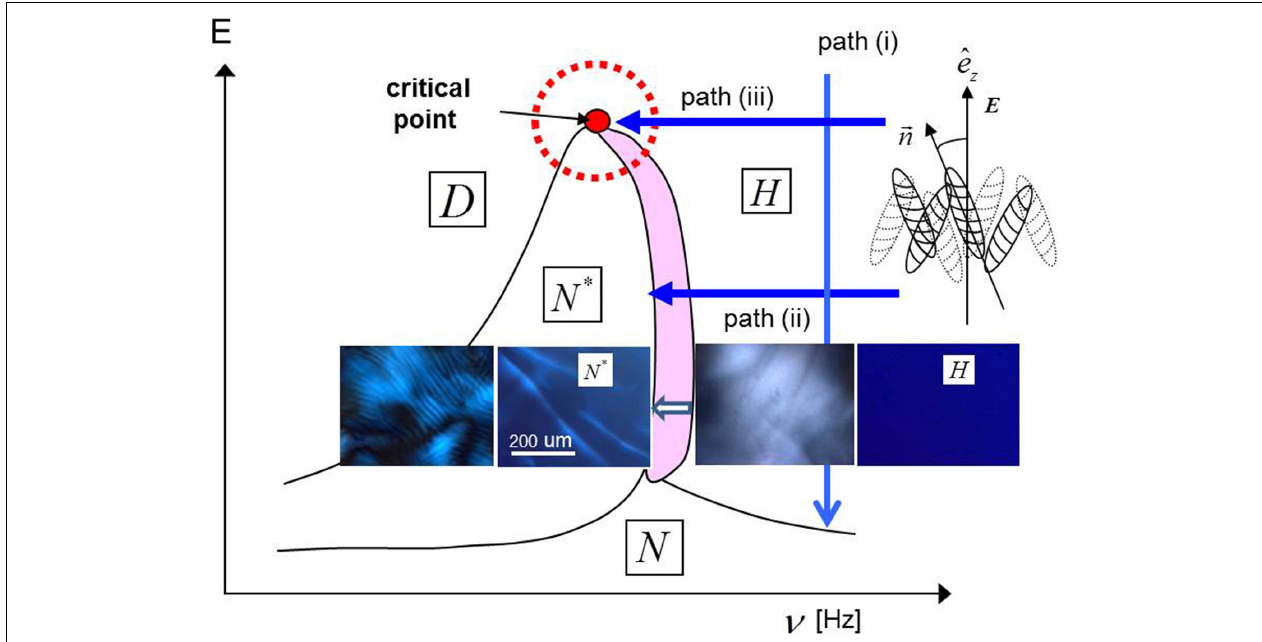
FIGURE 4 | A simplified phase/state diagram, indicating the pathways (i), (ii), and (iii). The depolarized images of the morphologies along path (ii) are shown. Transient, large and blurry nematic domains are seen in the pink